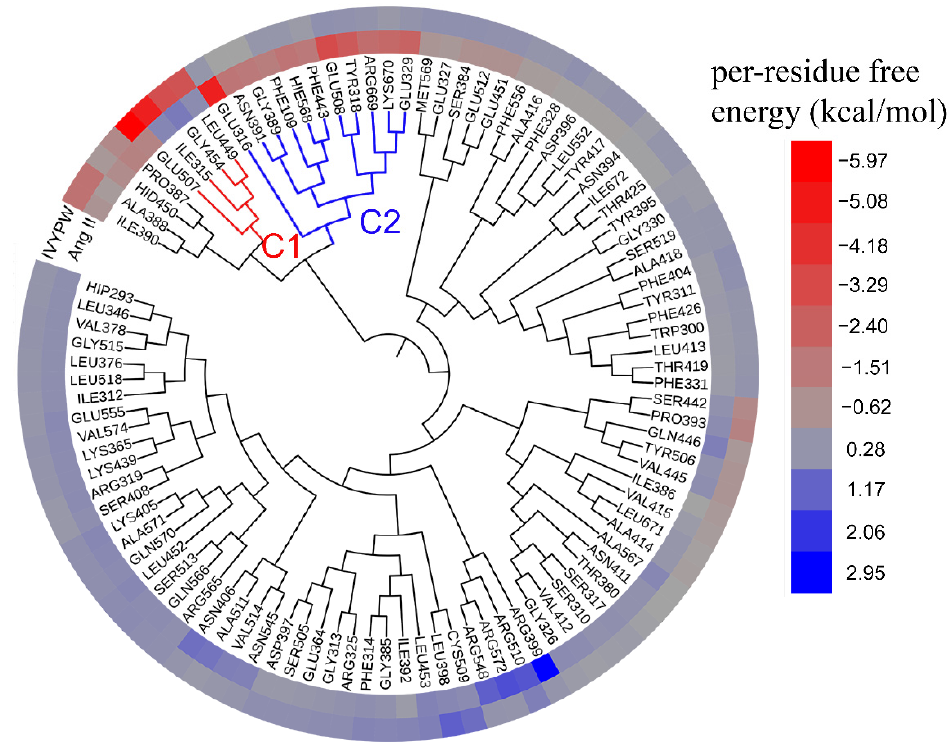
Figure 12. Hierarchical clustering tree with a heatmap of the residues providing contributions to the bindings of substrates to hDPP III based on per-residue energy decomposition. Contributions to binding energy that are beneficial to substrate binding are shown in red and gradually fade towards gray as the binding energy decreases. The binding energy contribution that is not conductive to substrate binging site is shown in blue, and gradually turns to gray as the binding energy decreases.